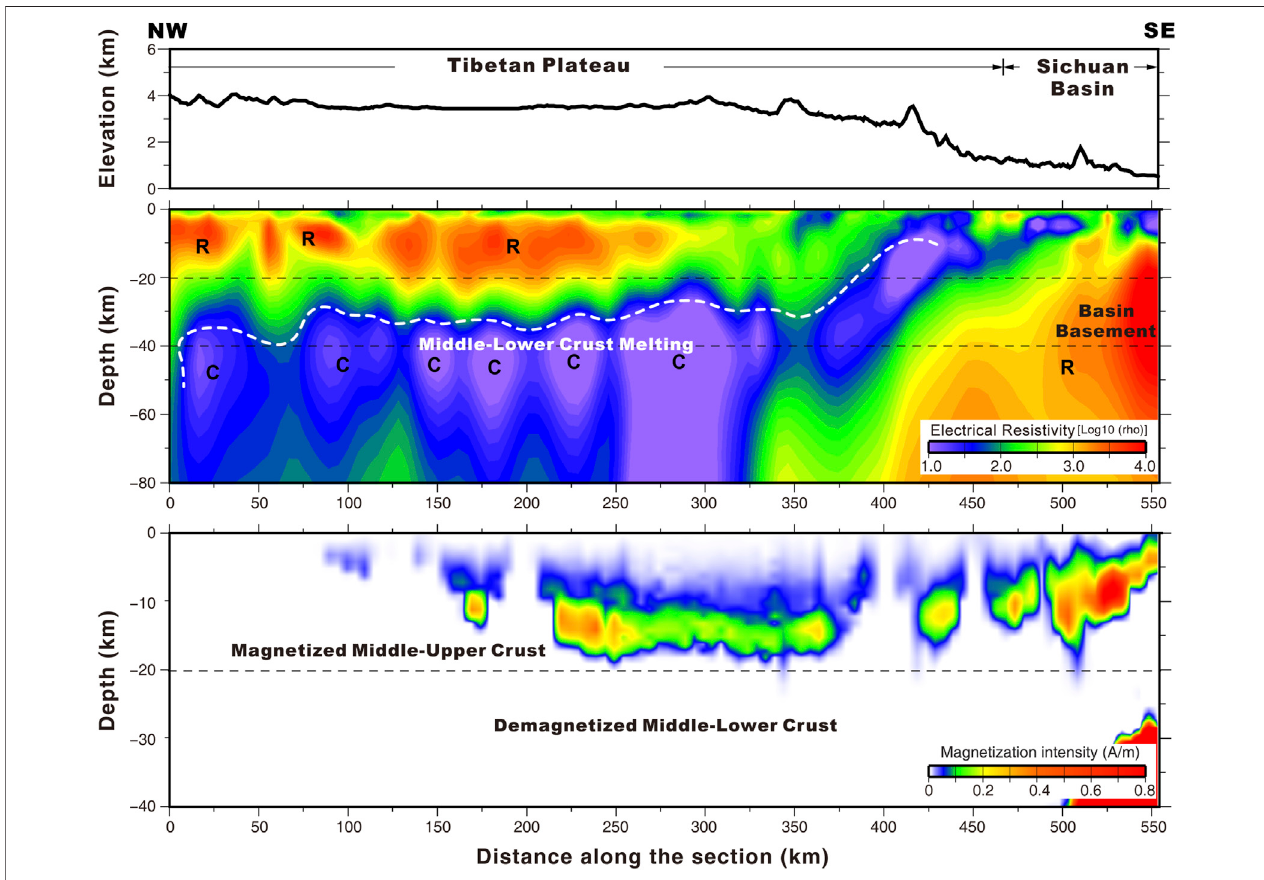
FIGURE 6 | Line one magnetotelluric survey pro fi le and magnetization distribution: (A) altitude (B) electrical resistivity and (C) magnetization distribution.